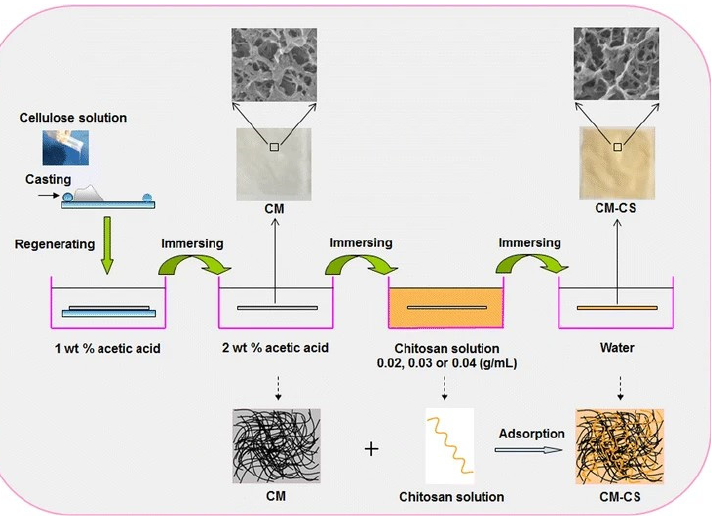
Figure 11. Schematic presentation of the approach of Cao et al. to the preparation of composite chitosan coated cellulose membrane Reprinted by permission from: [Springer Nature] [ CELLULOSE ] [131] (A facile and green strategy for the preparation of porous chitosan-coated cellulose composite membranes for potential applications as wound dressing, Cao, Zhenni, Luo, Xiaogang, Zhang, Hao, Fu, Zhen, Shen, Zhi, Cai, Ning, Xue, Yanan, Yu, Faquan), Copyright (2016).